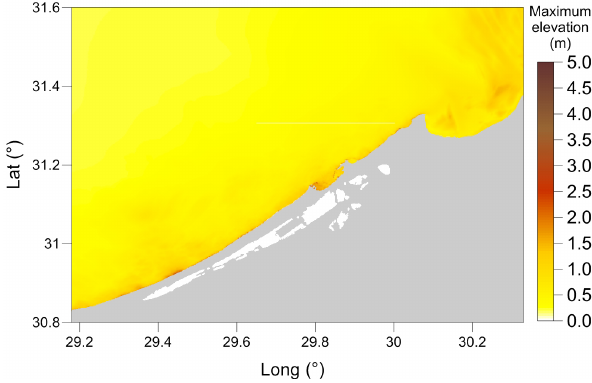
Figure 12. Sea surface maxima for the CA source, zoomed in on the area of Alexandria with grid 3 (200m